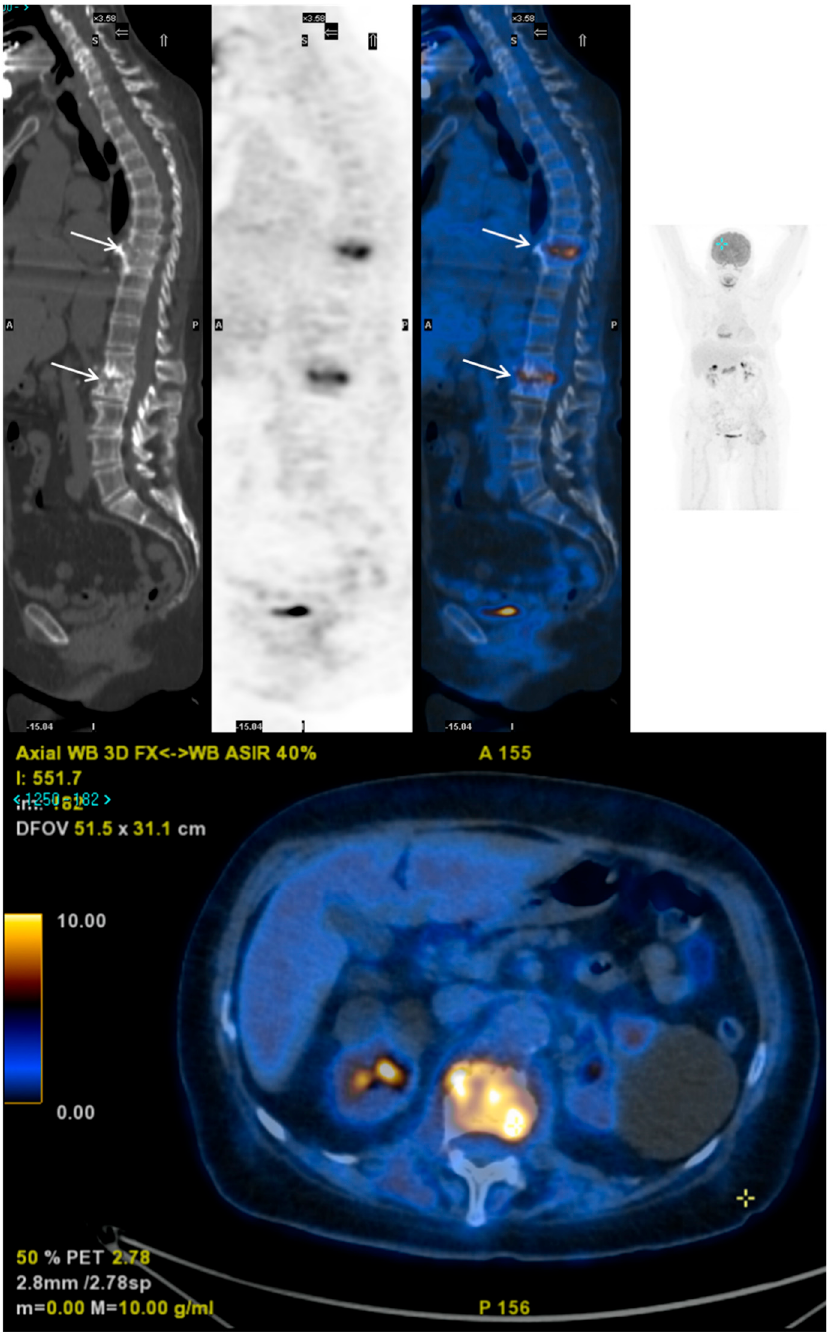
Figure 5. Pyogenic bifocal spondylodiscitis (T8-T9 and L1-L2) in a 70-year-old woman. FDG PET-CT showed increased SUV on both vertebral levels (arrows). Newer tracers for BS such as indium-111 labeled ( 111 In) biotin and streptavidin have been recently presented, with high sensitivity, specificity, and diagnostic accuracy for spinal infections [128]. Other new tracers include the technetium Tc-99m-ubiquitin-derived peptide which has a high affinity to areas with viable bacterial growth, in addition to radiolabeled antifungal tracers to distinguish fungal from bacterial infections